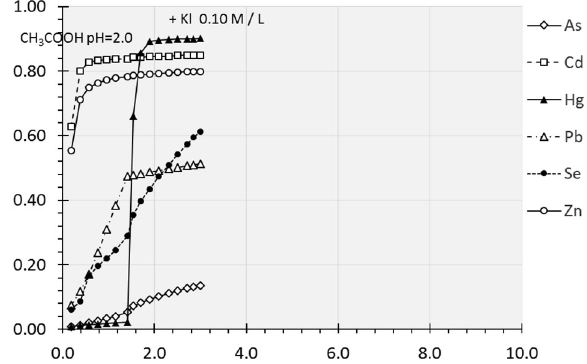
Fig. 11 Leachability of Hg: extraction yield versus volumes (L),